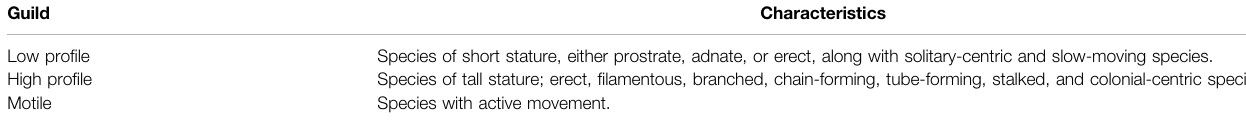
TABLE 1 | Diatom guild classi fi cation according to Passy (2007).